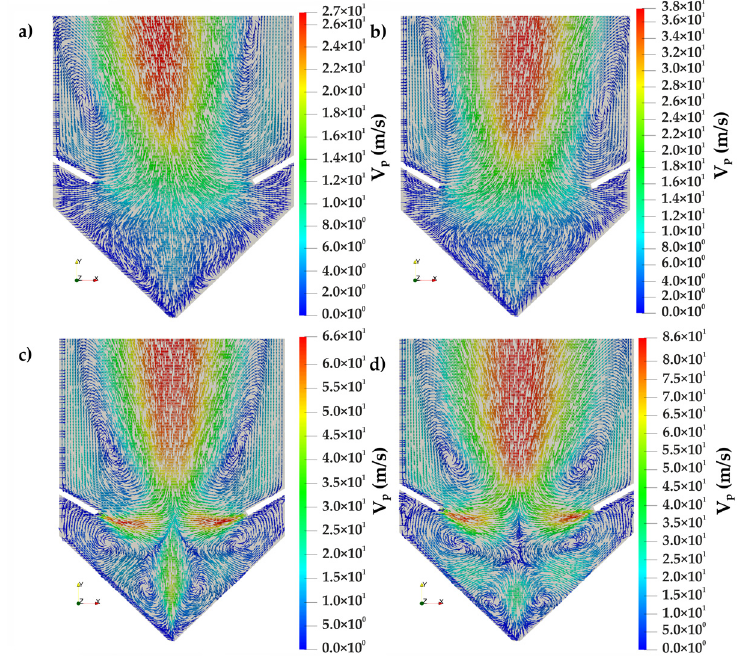
Figure 12. Time-averaged resultant vectors distribution of particle velocity near the grinding region as a function of the solid holdup and the nozzle inlet pressure: ( a ) 400 g and 0.5 bar; ( b ) 400 g and 1 bar; ( c ) 700 g and 0.5 bar; ( d ) 700 g and 1 bar.